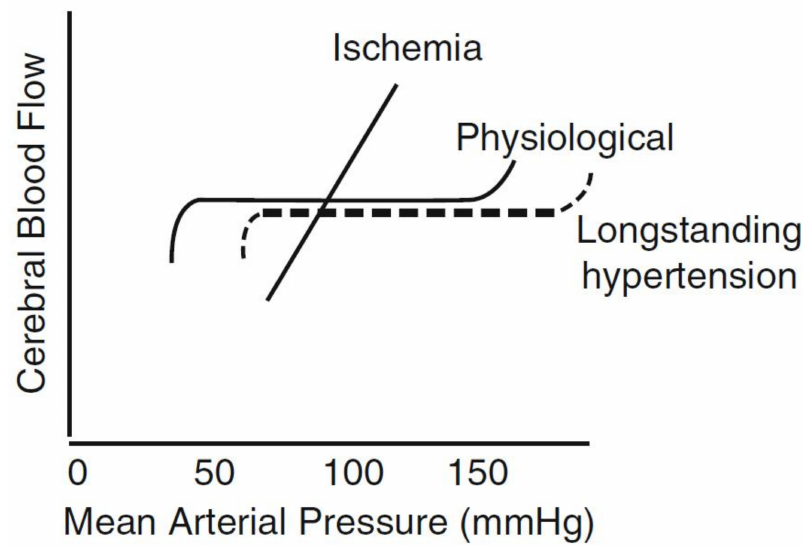
Figure 3. Auto-regulation of cerebral blood flow (CBF). In physiological conditions, CBF is auto-regulated over a wide range of perfusion pressures, from ~50 to 150 mmHg mean arterial pressure. This is shifted to the right in long-standing hypertension because of arteriolar hypertrophy. During acute ischemia, CBF becomes pressure passive, resulting in a marked reduction of CBF if the pressure drops too low. The threshold at which this becomes a problem will be higher for patients with long-standing hypertension, whose CBF auto-regulation is shifted to the right, because of arteriolar thickening. (Reproduced by permission Wolters Kluver from Spence, J.D. Treating hypertension in acute ischemic stroke. Hypertension 2009 , 54 , 702–703)